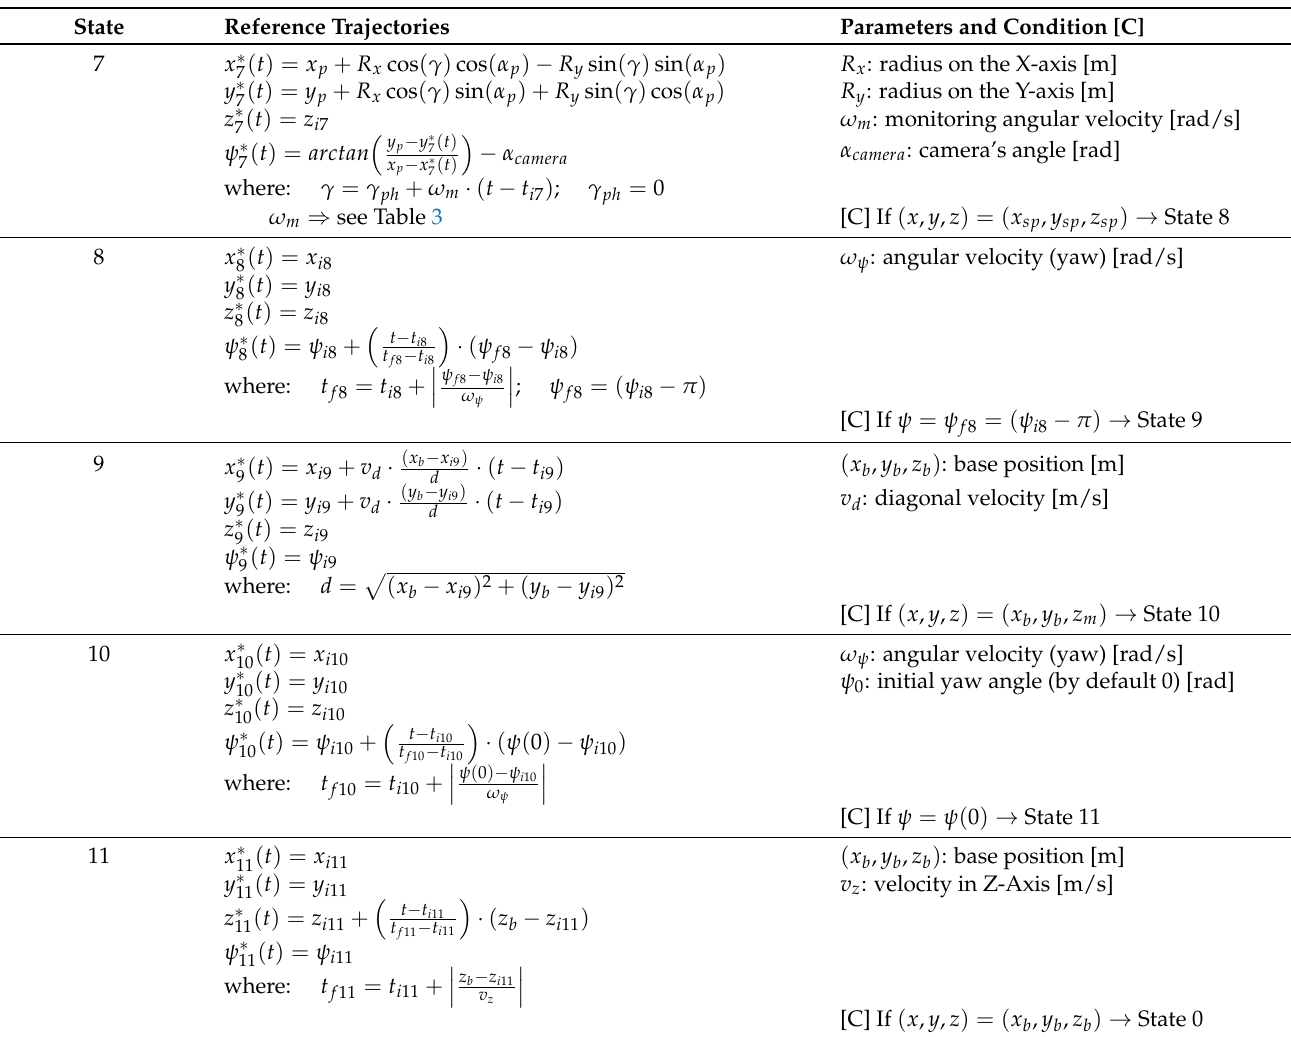
Table 2. Trajectory planner’s states for the monitoring process. (Part II—States from 7 to 11). Reference trajectories for the position ( x , y , z ) and yaw angle ( ψ ) of a quadrotor UAV monitoring a person whose position ( x p , y p , z p ) and orientation ( α p ) are